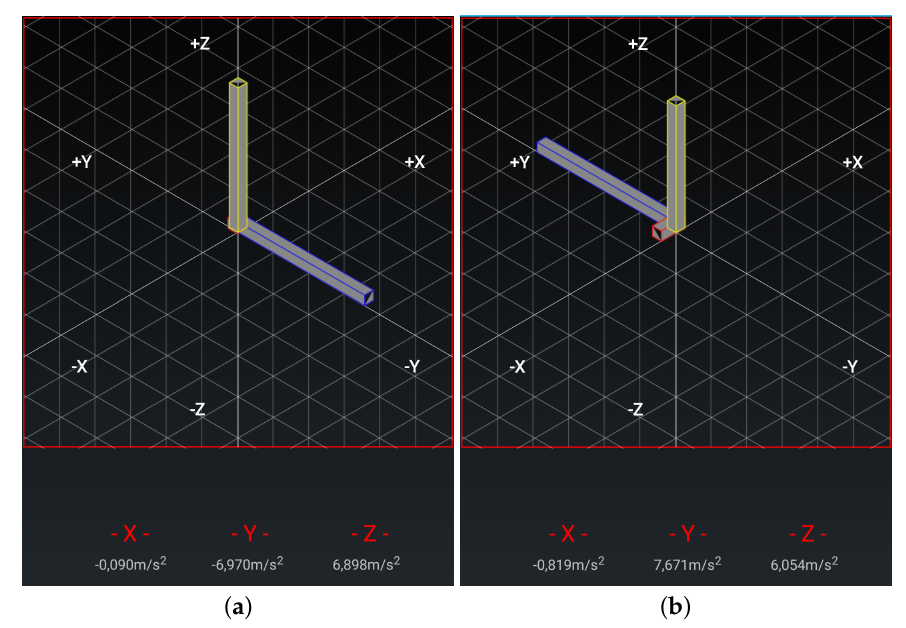
Figure 6. Gravity for the arm strength test: ( a ) Initial; ( b )